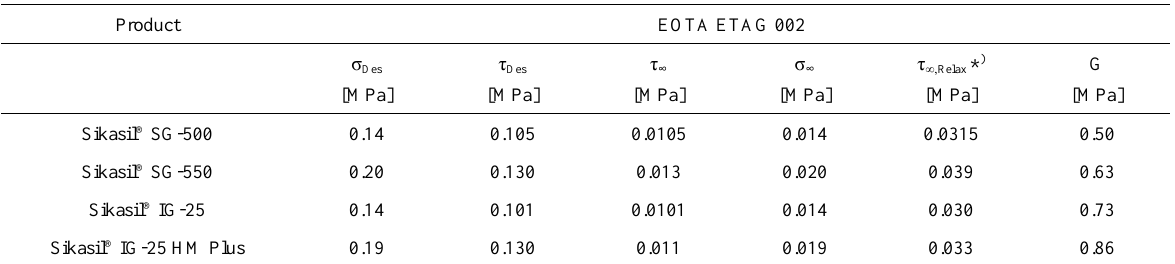
Table 1: Extended range of strength values for